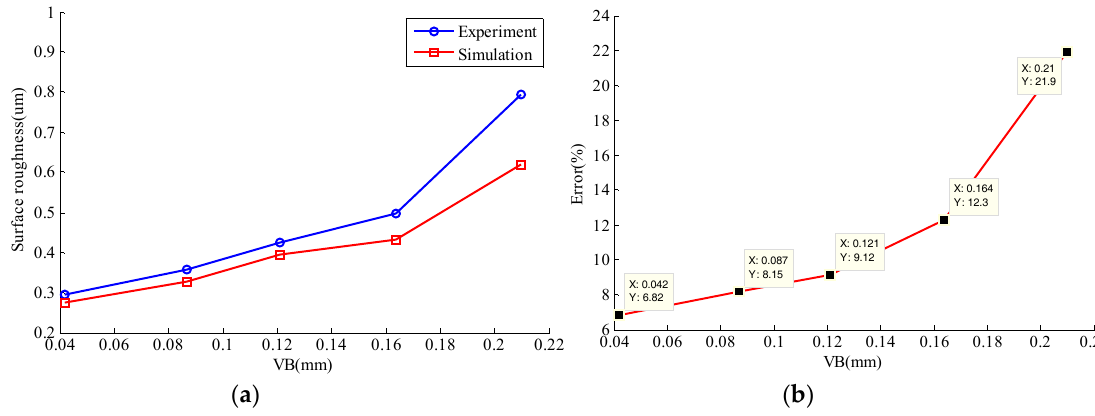
Figure 12. Surface morphology ( a ) experiment (Ra = 0.273 um); ( b ) without cutting vibration (Ra =